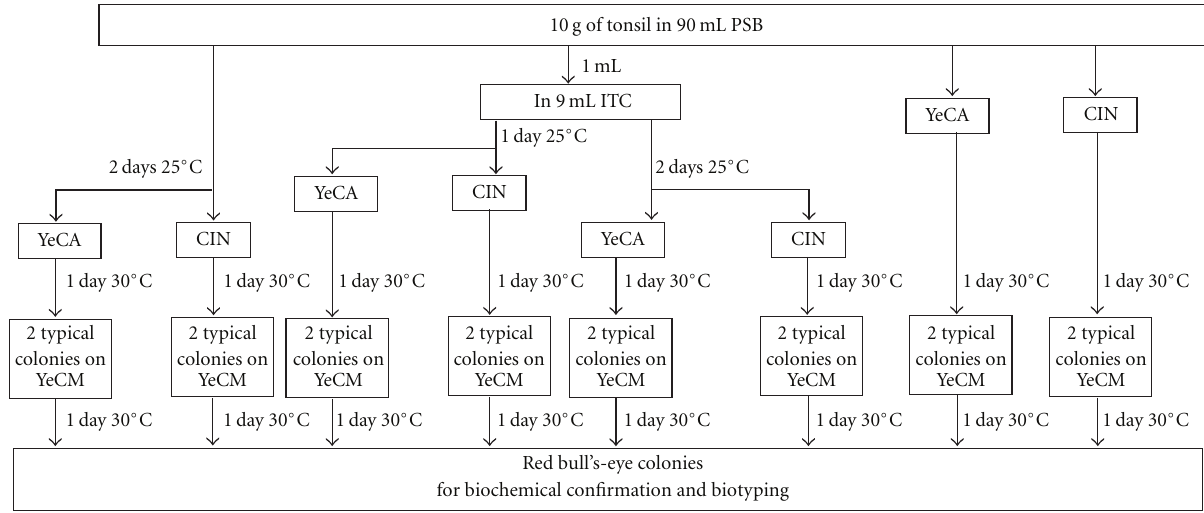
Figure 1: Overview of the methods used to isolate pathogenic Yersinia enterocolitica from pig tonsil in this study.